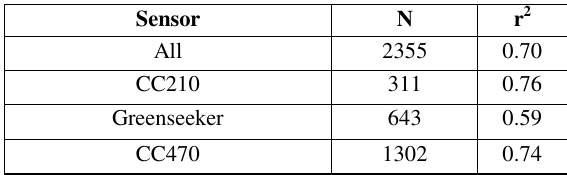
Regression results for fractional green cover on